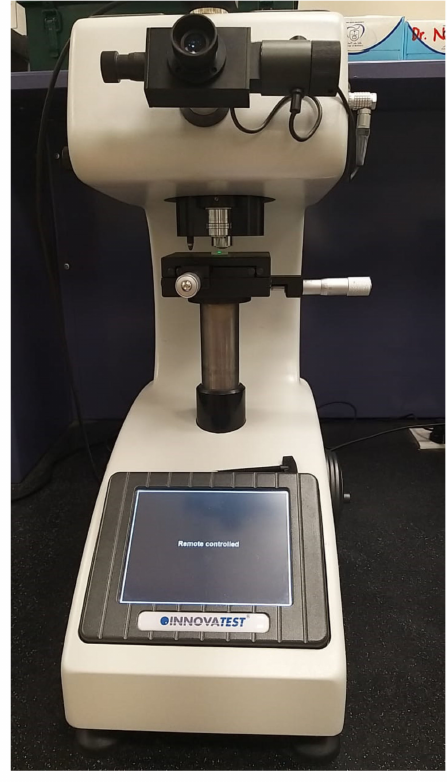
Figure 3. Microhardness testing on the teeth sample.